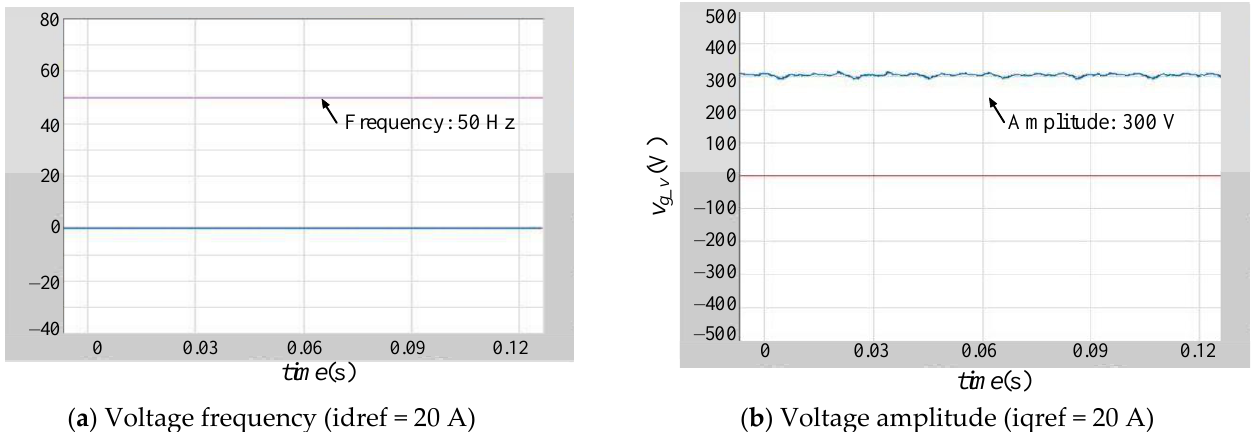
Figure 12. The frequency and amplitude of output voltage under secondary control ( f 0 = 50 Hz, V 0 = 300 V). ( a ) Voltage frequency ( i dref = 20 A); ( b ) Voltage amplitude ( i qref = 20